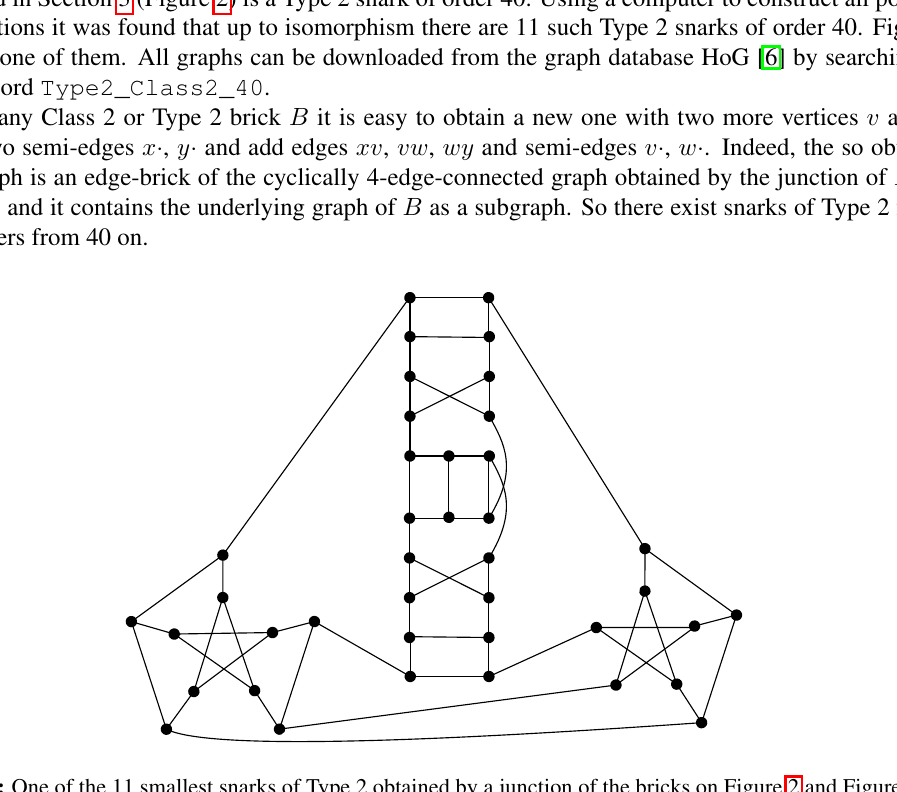
Question 1 Does there exist a Type 2 snark of order less than